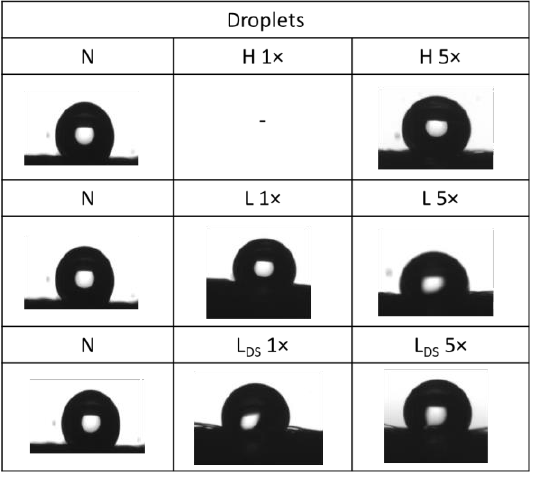
Figure 6. Droplets of the liquid with the surface of the back surface of the medical mask before and after laboratory washing with a standard detergent and rinsing with a disinfectant. The pictures of droplets confirm the hydrophobicity of the front/back surface of the medical mask before and after washing. There are differences in the appearance of the surface of the examined samples, in the form of protruding fibers. Their appearance